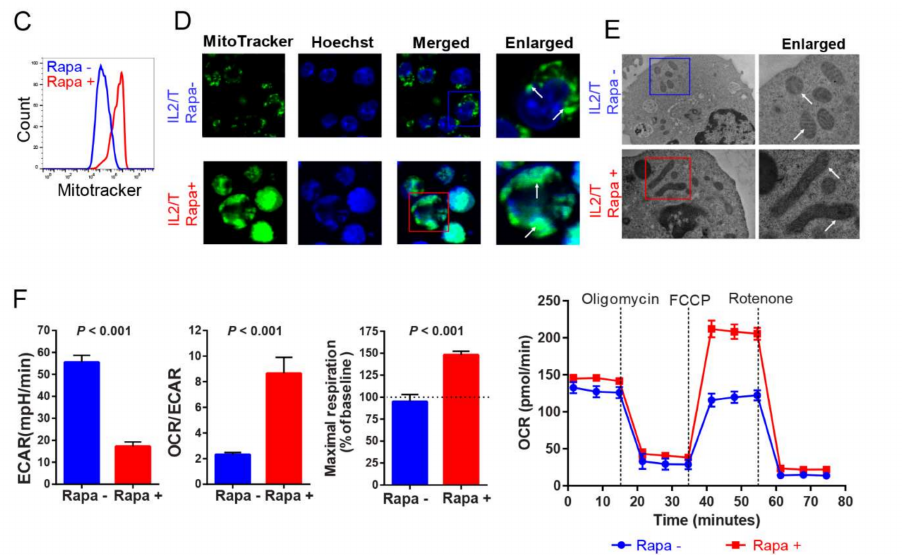
Figure 4. IL-2(Rapa+)/T-cells activate metabolic AMPK-ULK1-ATG7 pathway, promote mitochon- drial biogenesis and induce FAO metabolism. ( A ) Schematic diagram indicates splenic CD8 + T-cell culture for generating rapamycin-treated or not treated T-cells. CD8 + T-cells were activated by 0.1 nM OVAI-peptide in IL-2 containing media for 3 days. Following the wash, activated T-cells were treated or not treated with rapamycin (100 nM) in IL-2 containing media for 2 additional days to form IL-2/T E and IL-2(Rapa+)/T M cells. ( B ) The IL-2/T E and IL-2(Rapa+)/T M cell lysates were examined by the Western blot analysis (left panels). Bar diagrams (right panels) indicate relative fold expression of various molecules compared to b-actin loading control. ( C ) Rapamycin treated (red) or not treated (blue) T-cells were stained with MitoTracker green fluorescent stain and analyzed by flow cytometry to measure the mitochondrial mass. ( D ) Confocal microscopy shows mitochondrial mass as indicated by MitoTracker green staining in rapamycin-treated or not treated T-cells. MitoTracker green stained mitochondria (white arrows) and Hoechst (blue for nucleus). ( E ) Electron microscopy images show large tubular and small round mitochondria (white arrows) in rapamycin-treated and not treated T-cells, respectively. ( F ) Bar diagrams show basal extracellular acidification rates (ECAR, left bar diagram panel), basal ECAR/OCR ratio (middle bar diagram panel), and maximal oxygen consumption rates (right bar diagram panel; horizontal dotted line indicates a basal OCR, and OCR values above this line is a mitochondrial spare respiratory capacity (SRC) in respective groups; Line diagram shows OCR measured in real-time under basal conditions and in response to indicated mitochondrial inhibitors (red—rapamycin-treated; blue—not treated with rapamycin); p < 0.0001 after FCCP injection. Data from two to three independent experiments are presented as means ± SEM ( n = 4/group). * p < 0.05, ** p < 0.01, *** p < 0.001 by two-tailed Student’s t